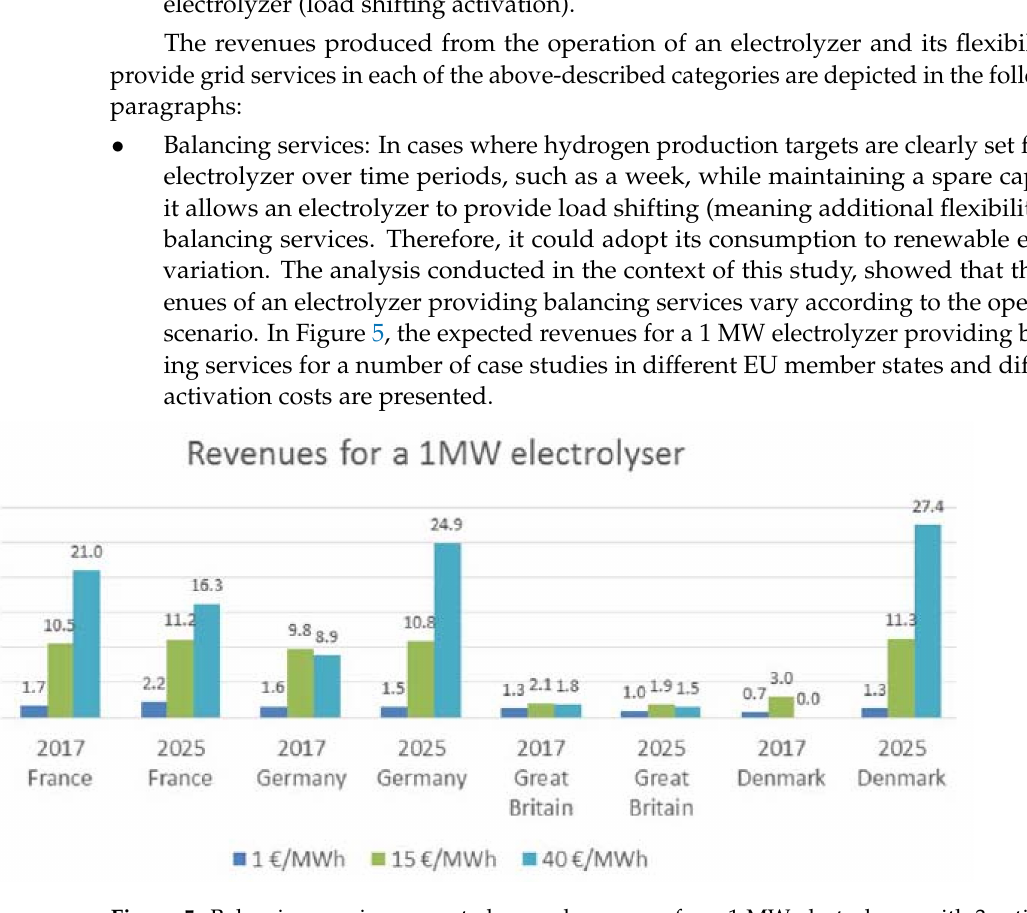
Figure 5. Balancing services expected annual revenues for a 1 MW electrolyzer with 3 activation costs